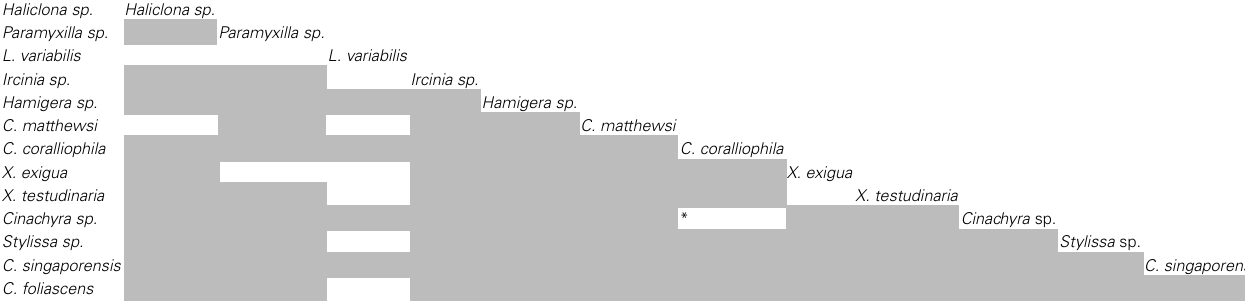
Table 3 | Significant PERMANOVA pairwise comparisons of the microbial communities amongst the different sponge species. Haliclona sp.